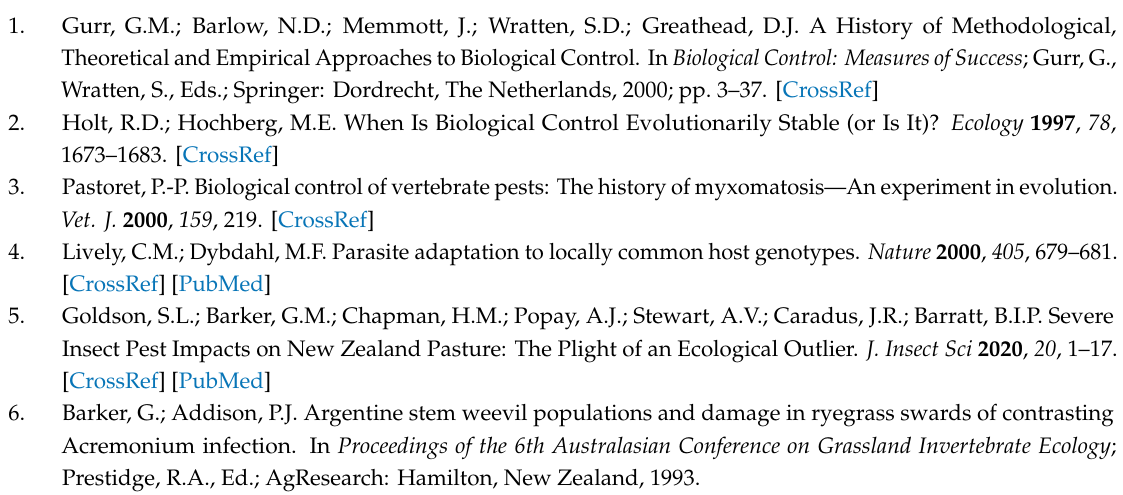
Figure S1: k-mer analysis of the short read sequencing dataset at k = 31. A k-mer distribution in the short read dataset before and after normalisation. The peak at 84–216 × coverage (highlighted in green) suggests a diploid genome with a haploid size of 967 Mb. The haploid peak (22–56 × coverage) indicates a high number of polymorphic sites in the single, male individual used to generate this dataset. BBTools [25] estimated 2.1 polymorphisms per 100 bp in this dataset. B Cumulative percentage of all k-mers vs. frequency. 72% of all k-mers are at 216 × or lower coverage, indicating that the remaining 28% of k-mers are repetitive. The earlier inflexion point at 48% suggests that k-mers in the region from 48–72% may also be from repetitive regions. Table S1: Repeat content of the subset draft assembly. We used RepeatModeler to detect repeats and the Dfam_3.1 Combined Database with RepeatClassifier to classify them [33,50], then used RepeatMasker to locate repeats in the assembly [35]. 1: Most repeats fragmented by insertions or deletions have been counted as one element. Table S2: Number of SNPs under selection using BayeScan [44] (Q < 0.01) or cross-population extended haplotype homozygosity (XPEHH) analysis [51,52] ( − log10p > 4). α is BayeScan’s locus-specific component of FST coe ffi cient [44]. Positive values suggest diversifying selection. Positive XPEHH scores suggest selection in the South group, and negative scores suggest selection in the North